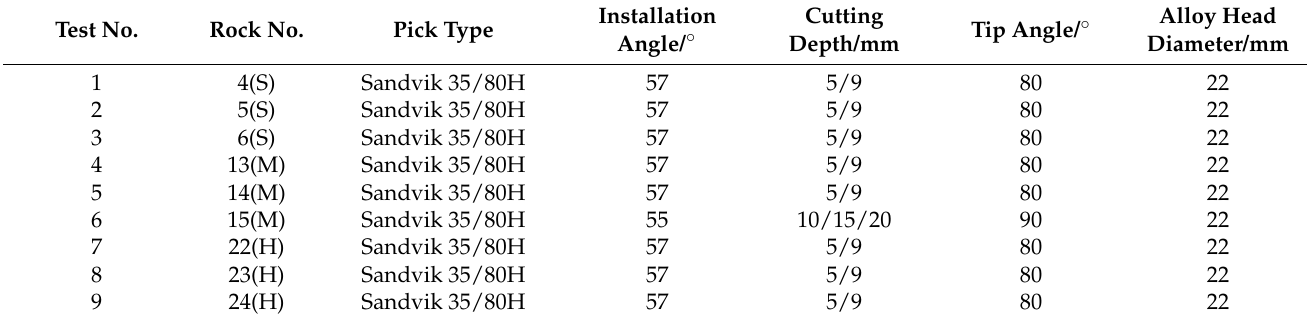
Table 2. Cutting conditions for the first prediction performance analysis.